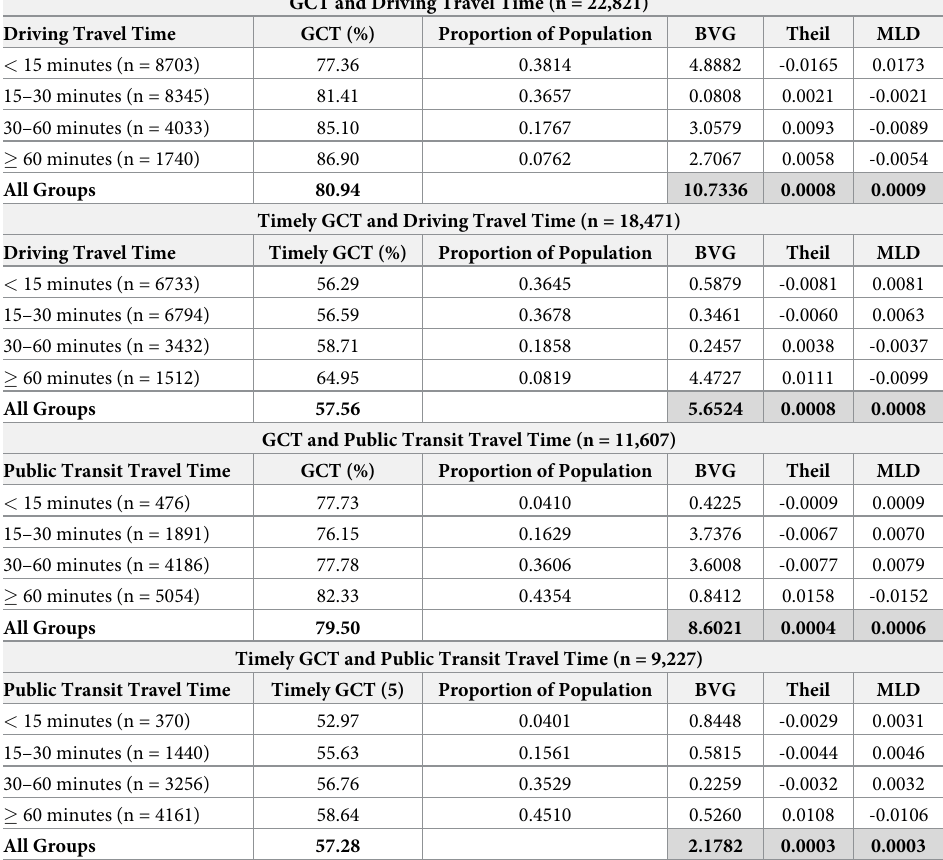
Table 3. Absolute and relative disparities in rate of GCT and Timely GCT between driving travel time and public transit travel time. GCT and Driving Travel Time (n =